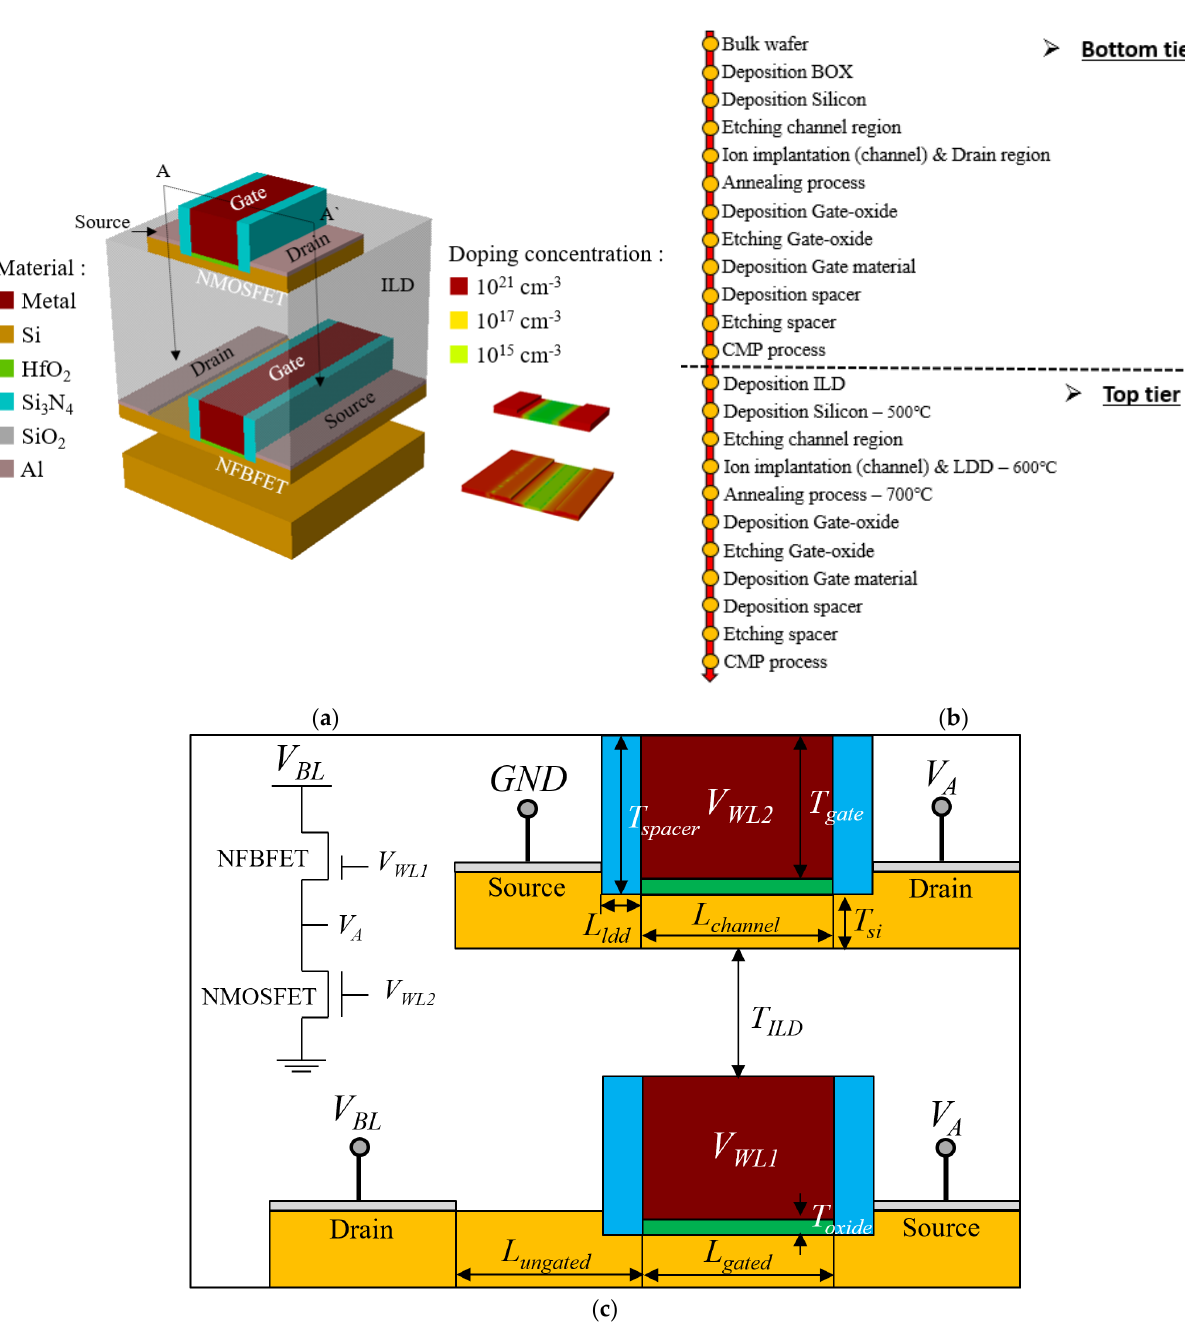
Figure 1. ( a ) A three − dimensional bird’s eyes view of the M3D − FBFET − SRAM cell, ( b ) its fabrication process sequence, ( c ) its cross − section of A − A ` and circuit diagram. Table 1. Structure parameters of the M3D-FBFET-SRAM cell.